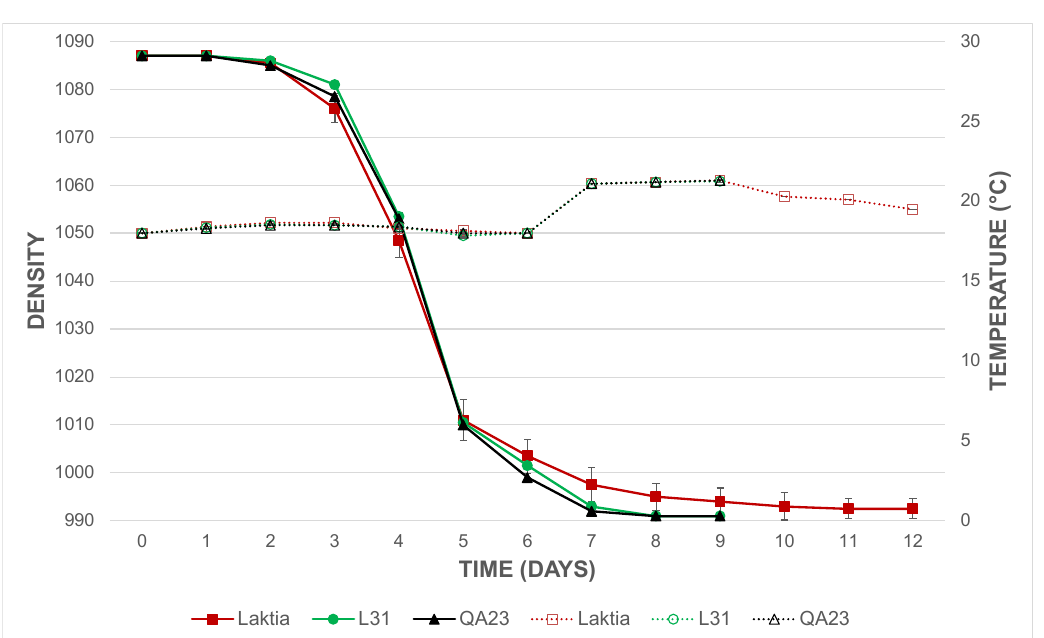
Table 1. Oenological parameters of the different yeasts on the last day of fermentation. Different letters in the same row indicate statistically significant differences according to the Student–New- man–Keuls (S–N–K) test. α = 0.05.